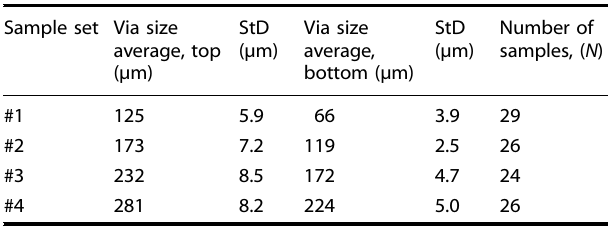
Table 1. Via diameters. Sample set Via size average,